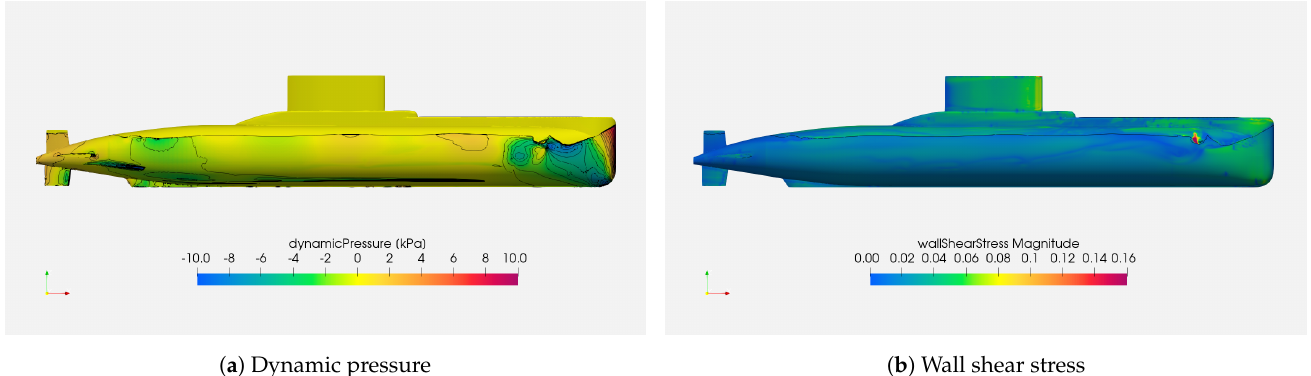
Figure 14. Numerical prediction of dynamic pressure and wall shear stress distribution around a Type 209/1300 submarine at condition 1 H / D = 0.33 and Fr = 0.194. Dynamic pressure distribution includes contour lines between range limits with steps of 1000 [Pa]. Wall shear stress distribution includes the free surface profile.